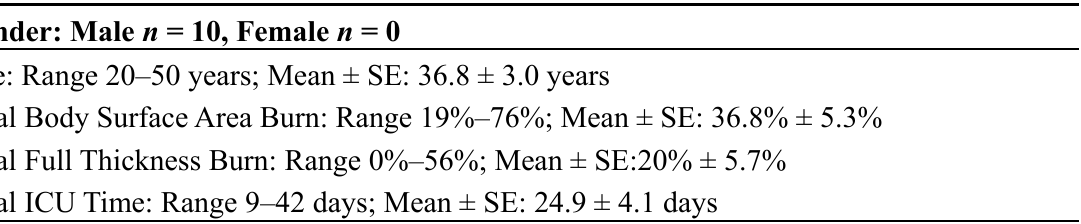
Table 1. Demographics of Burn